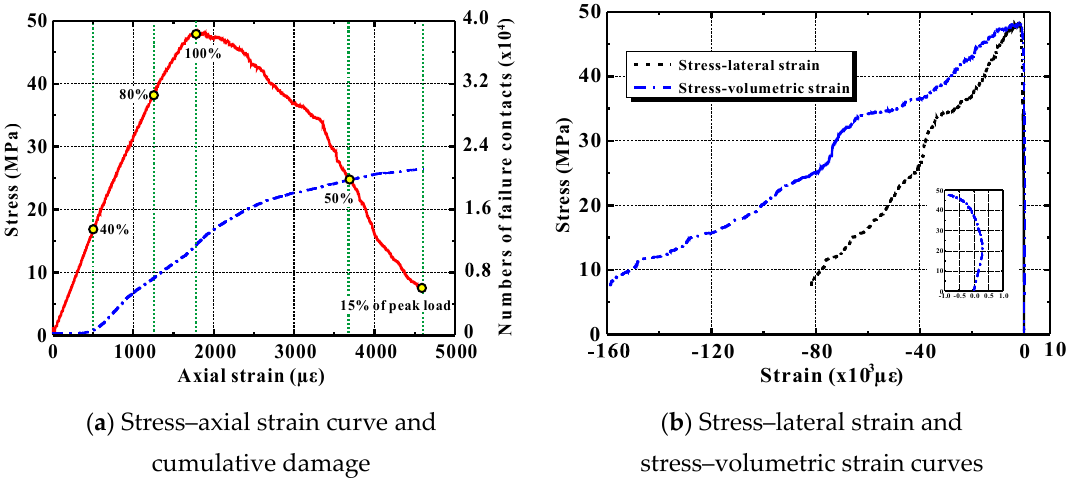
Figure 6. Numerical stress–strain relationships of ordinary concrete under uniaxial compression.